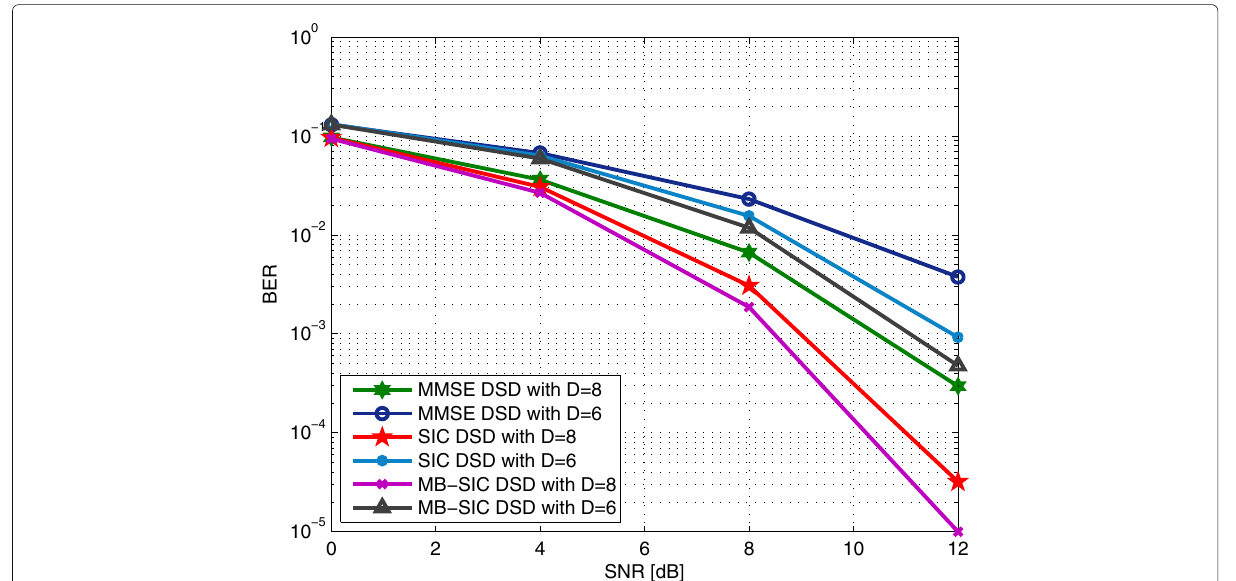
= 1 transmit antenna per user, N = 4 classes of users, N k , n